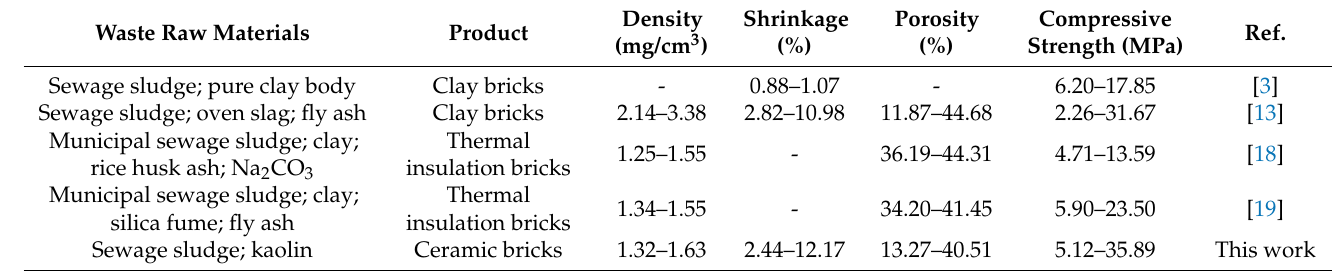
Table 4. Product properties of various sintered sludge-based